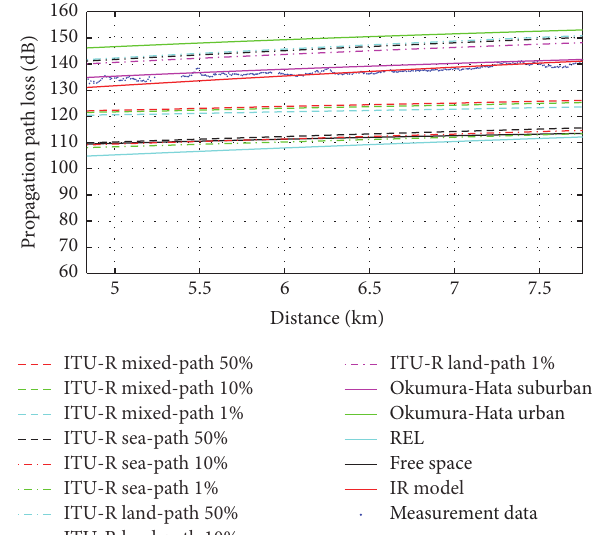
Figure 28: Simulation verification based on measurement data